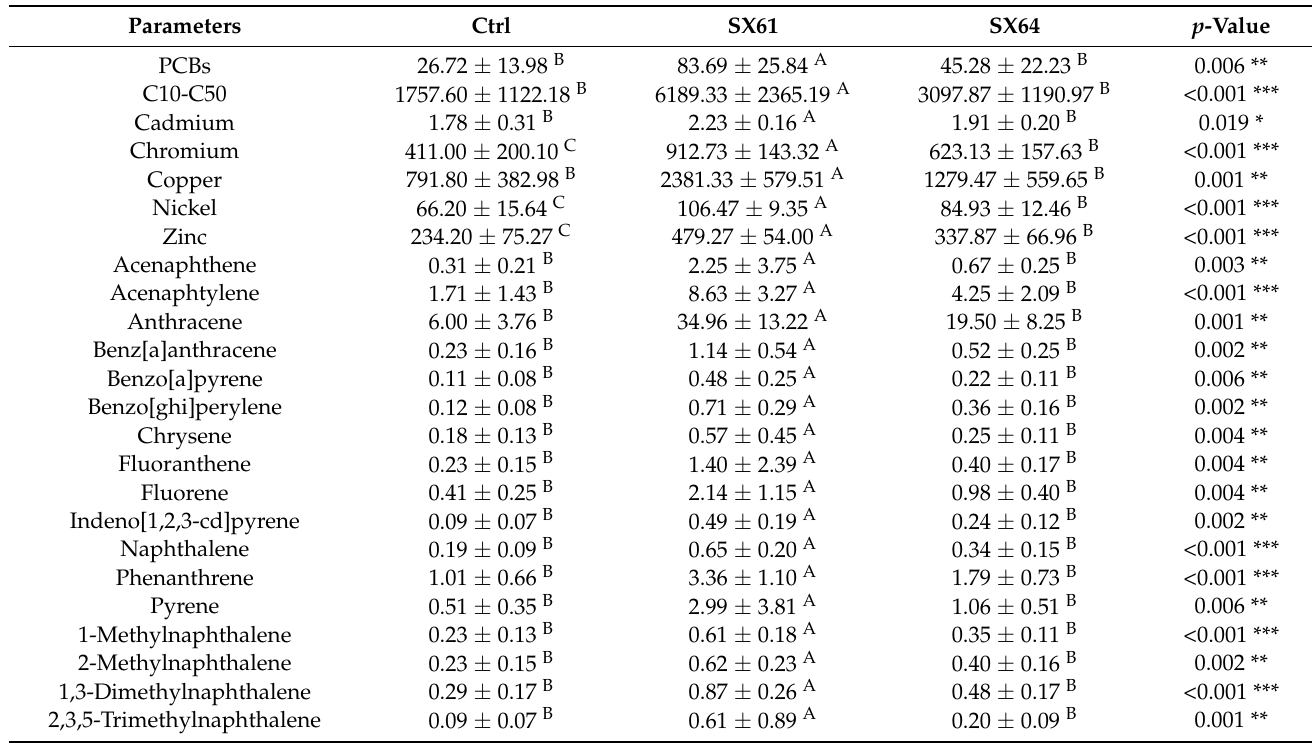
Table 1. Initial soil contaminant